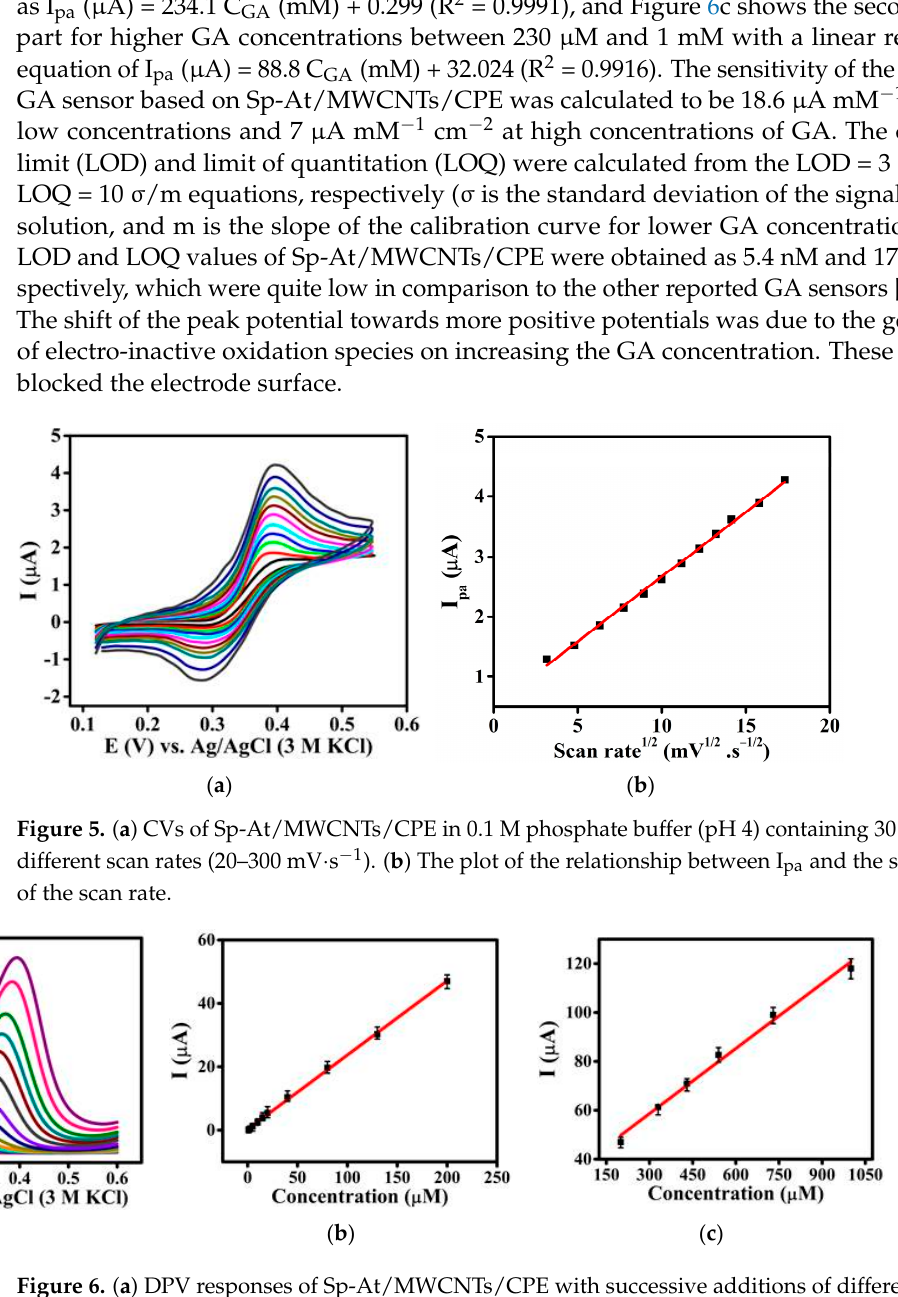
( c ) Figure 7. ( a ) Amperometric response of Sp ‐ At/MWCNTs/CPE with successive additions of different concentrations of GA from 250 nM to 550 μ M in 0.1 M phosphate buffer (pH 4) at 0.35 V. Inset: partial magnified view of the calibration curve for low concentrations of GA from 250 nM to 3 μ M. The current ‐ GA concentration calibration curve for ( b ) low and ( c ) high concentrations of GA.